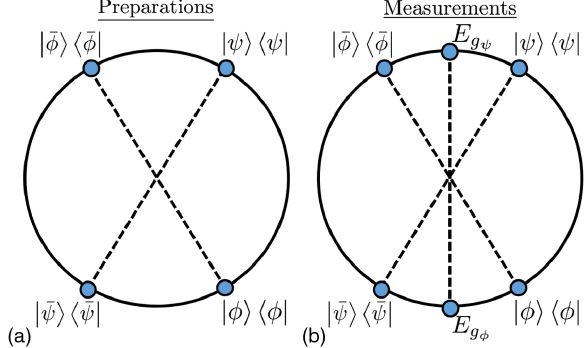
FIG. 1. The quantum states and measurements in our scenario, depicted as Bloch vectors in an equatorial plane of the Bloch